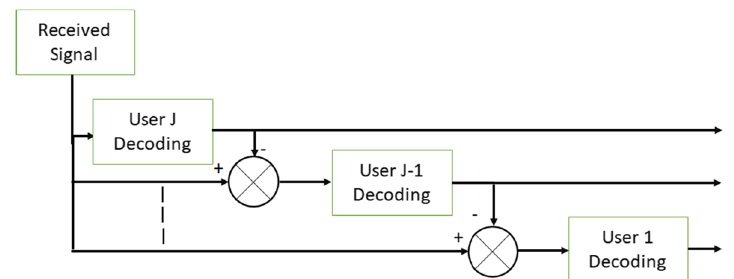
Fig. 3 J-user SIC